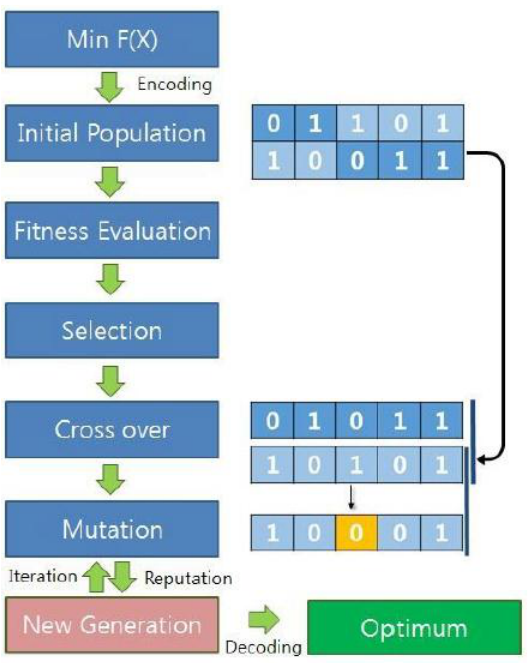
Figure 1. Process of GA Algorithm.